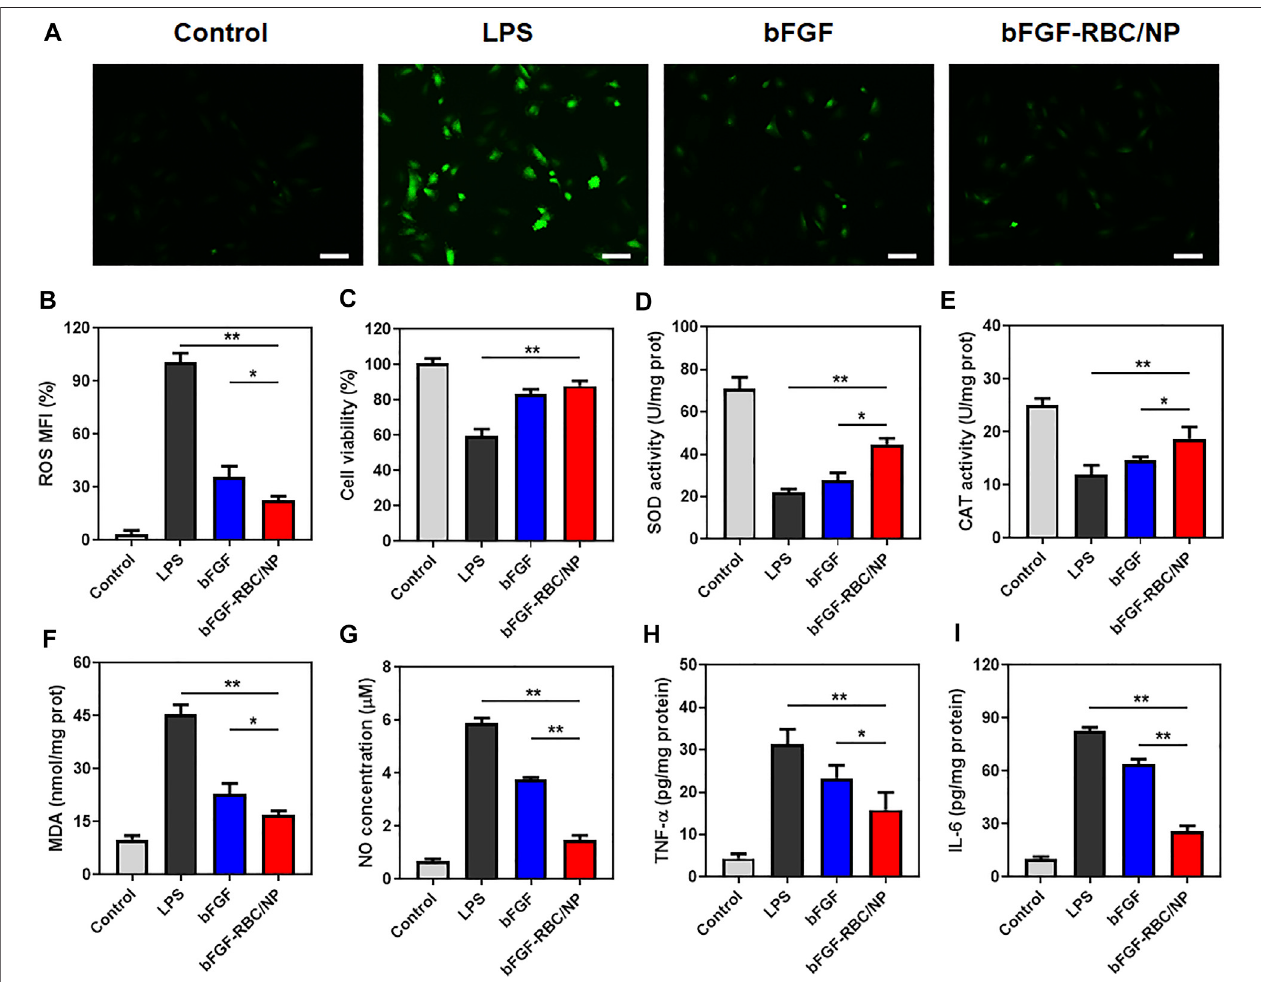
FIGURE3| Invitro antioxidativeandanti-in fl ammatoryef fi cacyofbFGF-RBC/NP.LPS-stimulated(1 μ g/ml)H9c2cellsweretreatedwithbFGFandbFGF-RBC/NP (50 ng/ml)for24 h. (A) Intracellularreactiveoxygenspecies(ROS) ofeach group. (B) Semi-quantitativeanalysisofthemean fl uorescenceintensity(MFI)ofROS. (C) Cell viability of each group. The levels of (D) SOD, (E) CAT, (F) MDA, and (G) NO in cells of each group. The contents of (H) TNF- α and (I) IL-6 in the supernatant. Data are expressed as the mean ± SD ( n = 3). Scale bar = 50 um. * p < 0.05 and ** p < 0.01.